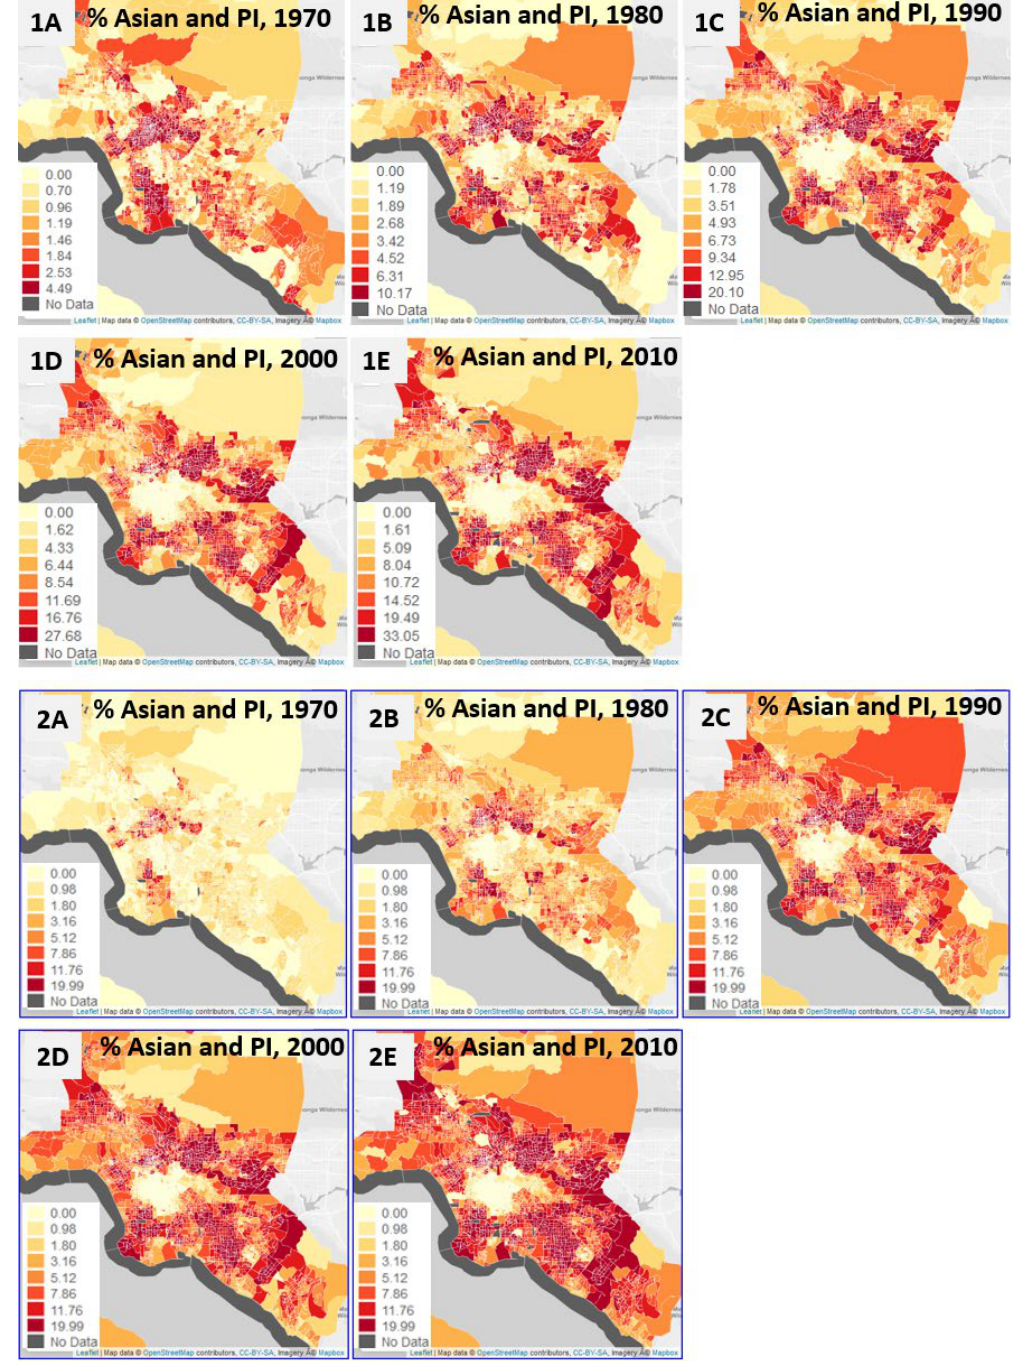
Figure 1. The distribution of the percentage of Asians and Pacific Islanders in 1970, 1980, 1990, 2000, and 2010, in Los Angeles. Maps (1A) to (1E) have different classification intervals, while maps (2A) to (2E) have the same classification intervals.